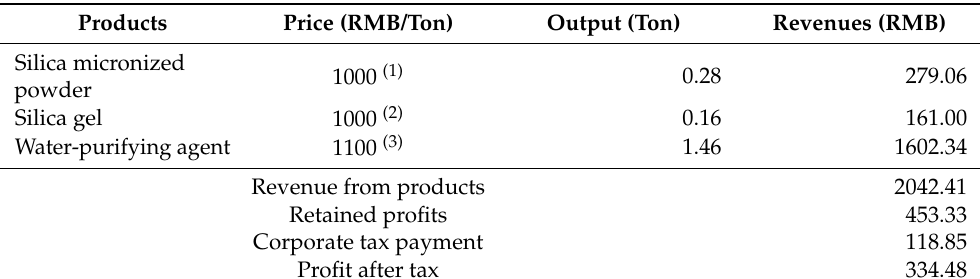
Table 5. Revenue estimation of major element products for per ton of silver